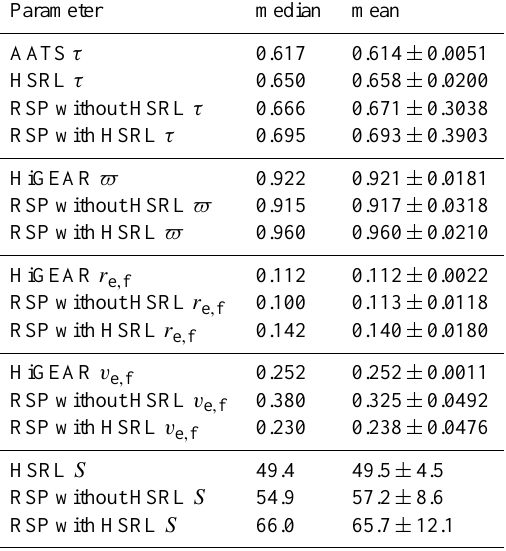
Table 5. Retrieved aerosol results for validation data. The mean and median are calculated for the set of optimizations. Uncertain- ties (denoted ± ) are the median value returned by the optimization routine. Optical thickness ( τ ), single scattering albedo ( $ ) and the backscatter to extinction ratio ( S ) are expressed at